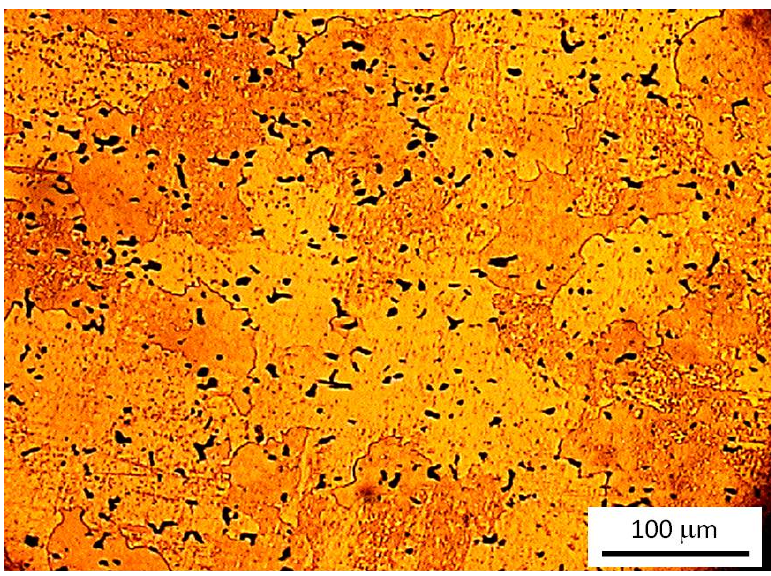
Figure 1. Light microscopy image of W-1% La 2 O 3 showing the distribution of dispersed particles of larger size.